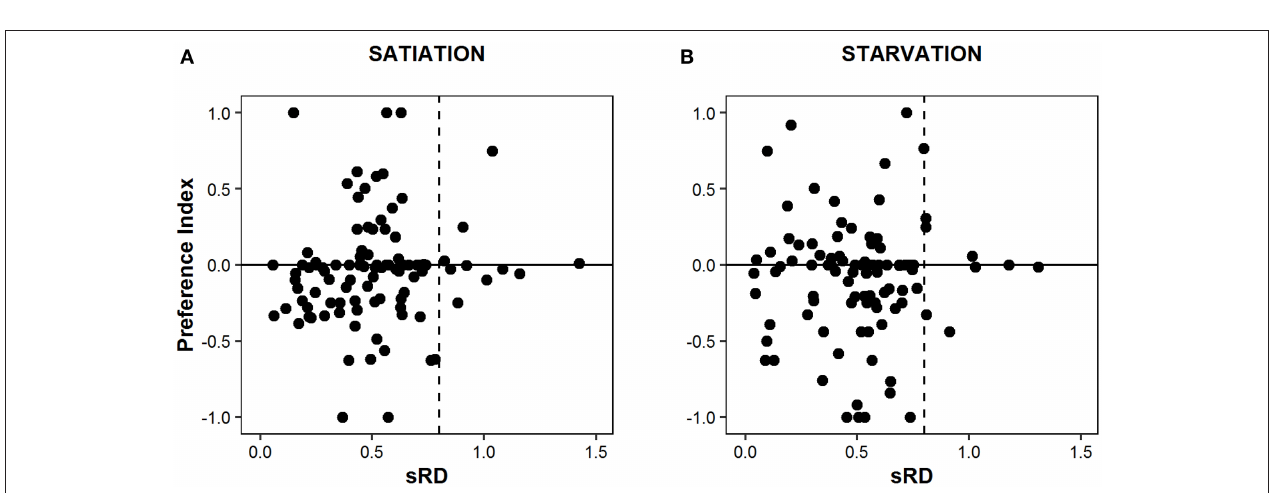
FIGURE 6 | Variability of Sparus aurata post-flexion larvae Preference Index (PI) in function of their standard RNA:DNA ratio (sRD) at satiation (A) and starvation (B) conditions. Negative values of the Preference Index indicate a preference for coastal water, while positive values indicate a preference for lagoon water. The vertical dashed line represents the 0.8 sRD critical level determined for gilthead seabream larvae using the equations of Buckley (1984) and Buckley et al.